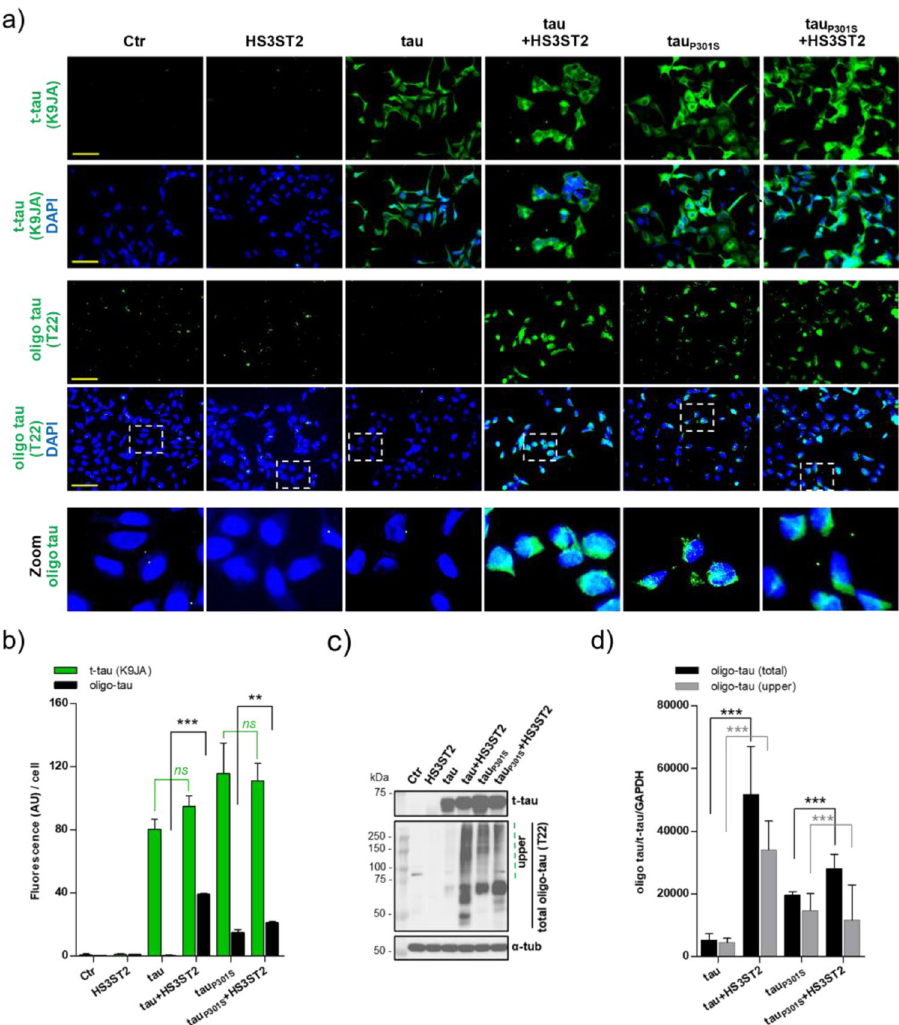
Figure 3. HS3ST2 promotes tau oligomerisation in cells expressing tau and tau P301S . ( a ) Total tau (t-tau) and oligomeric tau (oligo-tau) were respectively stained with the K9JA and T22 antibodies. Cells were counterstained with DAPI to visualize nuclei (blue). Images were acquired with microscope IX81 Olympus, magnification 20x, scale bar 100 µm. ( b ) Fluorescence intensity was quantified in cells by using ImageJ (2 fields, or 3 when cell density was low), t-tau signal (K9JA, green histograms) and oligo-tau signal (T22, black histograms) were compared between cells expressing or not HS3ST2. Mean values ± SD ( n = 3) are represented. ( c ) T-tau (K9JA) immunoblotting (upper blot) was performed in RIPA cell lysates and proteins were detected in all the MAPT transfected cells. Oligo-tau (T22) immunoblotting (medium blot) was performed on cell lysates extracted with high salt (500 mM) Sarkosyl buffer. Stable tau aggregates are highlighted in the upper part of the blot (green dotted line). An anti-α-tubulin (α-tub) antibody was used as loading control (RIPA). ( d ) Oligo-tau and t-tau signals quantification were performed with ImageJ in the different cells (black histograms: oligo-tau/t- tau/GAPDH, grey histograms: upper oligo-tau/t-tau/GAPDH) and the average signal from two experiments was compared. Mean values ± SD ( n = 3) are represented. Image or immunoblot analyses were calculated by one-way ANOVA with Tukey’s test, as indicated (*** P < 0.001; ** P < 0.01; ns = not significant). Experiments were reproduced twice with similar